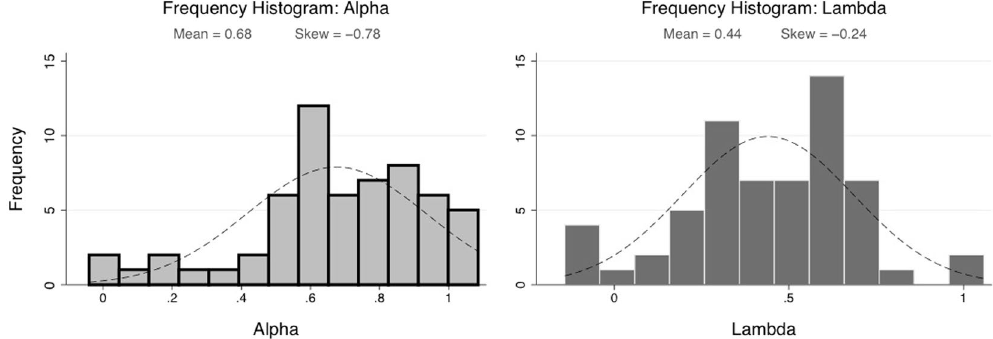
Figure 2. Frequency Histograms for Risk and Ambiguity Parameters. Histograms depict the distribution of alpha (left) and lambda (right) values within this sample. Normal distribution fit is shown with dashed